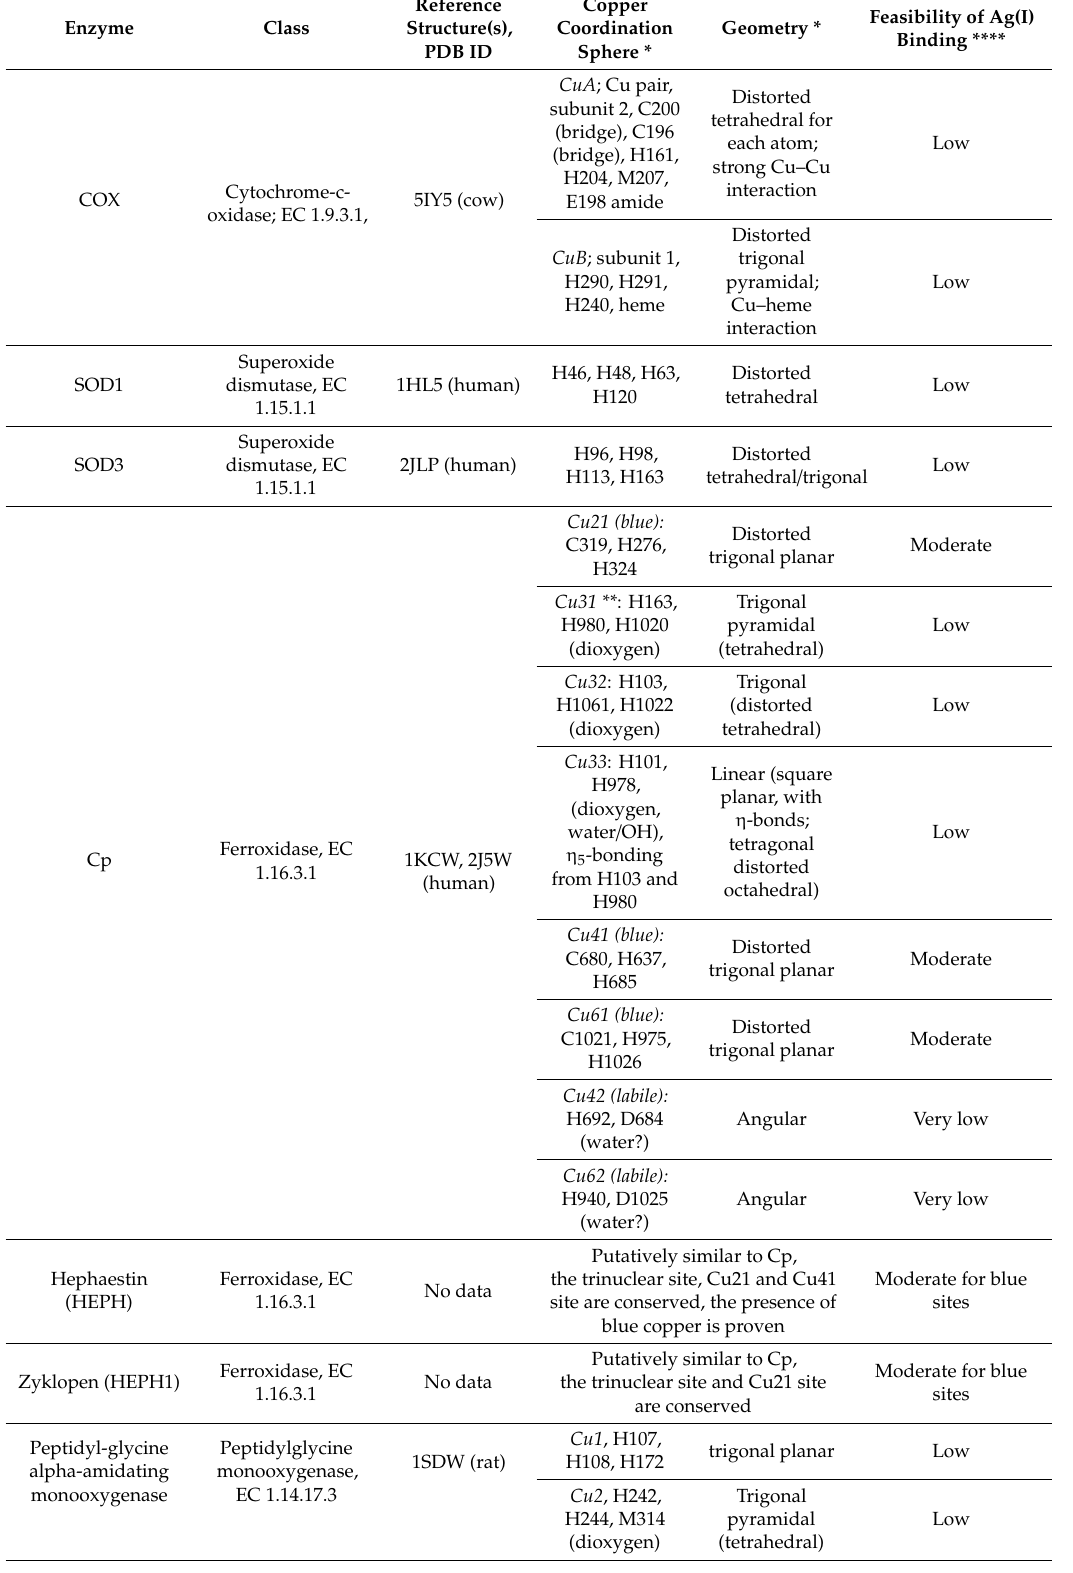
Table 2. Theoretical assessment of the ability of Ag(I) to replace copper in the active centers of the major cuproenzymes of